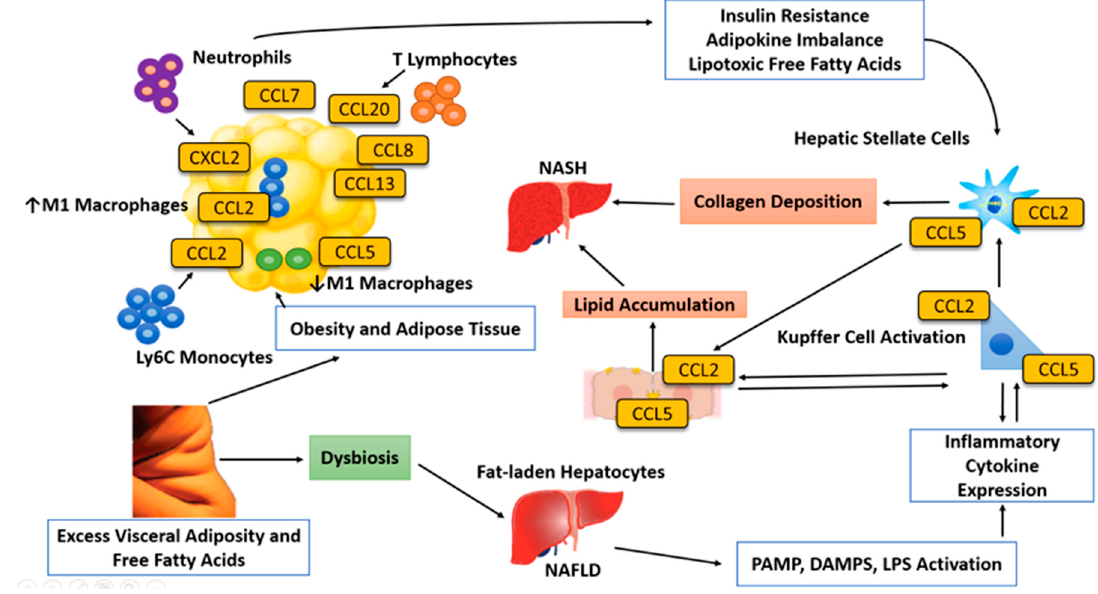
Figure 1. The pathogenesis of nonalcoholic steatohepatitis (NASH) is not completely understood. It seems the mechanism leading to NASH is multifactorial. Obesity is a strong contributing factor to nonalcoholic fatty liver disease (NAFLD) progression due to liver steatosis is related to lipotoxicity and cellular stress, which result in hepatocyte injury. Evidence has shown a strong relationship between obesity and gut microbiota configuration in humans [21,22]. Obesity has been related to modify the gut microbiota and gut microbiota has demonstrated a modifier role of metabolic and end organ complications of obesity such as NAFLD/NASH. The imbalance of gut microbiota (dysbiosis) leads to increased pathogen-associated molecular patterns (PAMPs). Moreover, dysbiosis is related to an increased exposure to bacterial products coming from the gut such as gram-negative-derived lipopolysaccharides (LPS). Molecular pattern molecules (DAMPs) and PAMPs act on receptors localized on hepatic cells leading to recruitment of neutrophils, macrophages, and other components of the innate immune response. Kupffer cells are sensors of liver tissue damage and they become activated through PAMPs, by increased levels of LPS and by DAMPs. The activated Kupffer cells release proinflammatory cytokines and chemotactic factors such as chemokine C-C motif ligand (CCL). Consequently, hepatic stellate cells are activated. Finally, this process causes an immoderate production of extracellular matrix leading to progressive fibrosis.